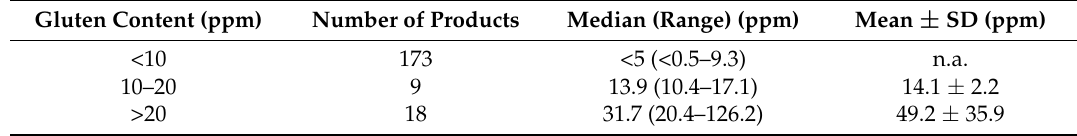
Table 1. Level of gluten contamination in the 200 examined